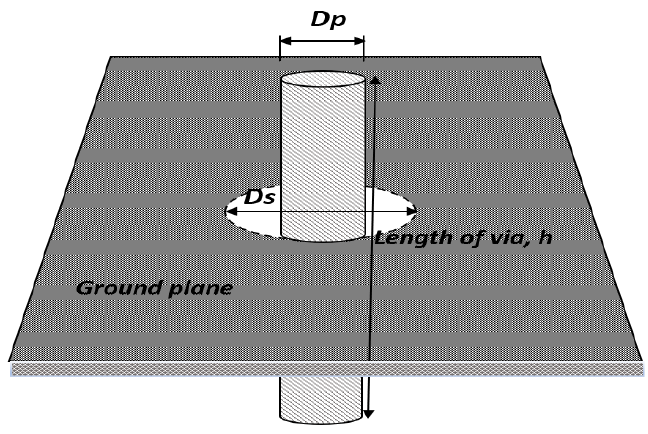
Figure 2. Via model through ground plane perspective.